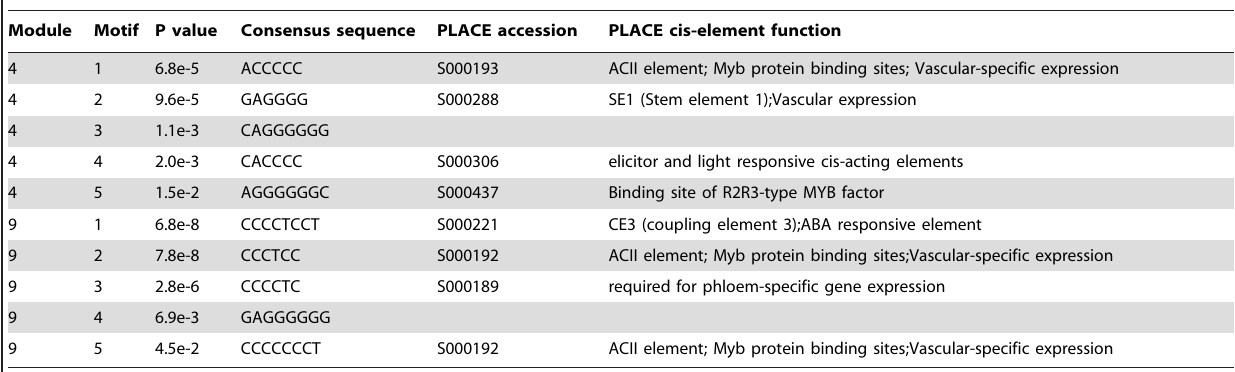
Table 2. Overrepresented cis-regulatory elements in Module 4 and Module 9 of PGCN.